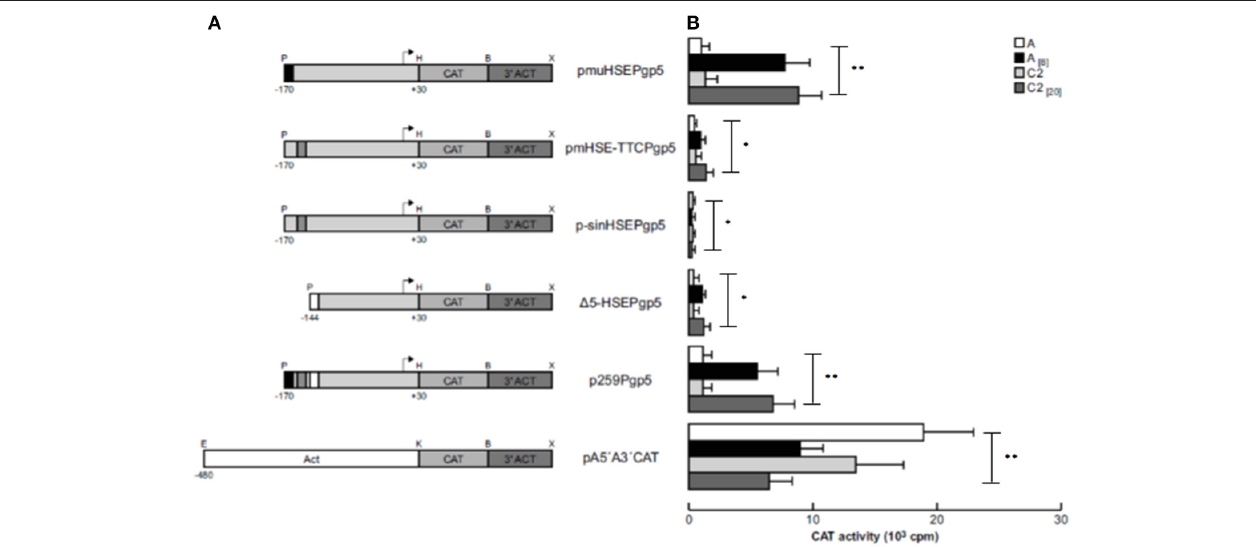
FIGURE 3 | Functional identification of the putative HSE element in the region from − 170 to − 111 bp of the EhPgp5 gene core promoter. (A) Schematic representation of the constructs used for the transfection assays. All of the plasmids contain the CAT reporter gene and the 3 ′ -flanking actin region (3 ′ ACT). Arrows, transcription initiation sites. P, Pst I; H, Hind III; B, Bam HI; X, Xho I; E, EcoR I; K, Kpn I. CdxA, YY1, and HSE motifs are in black, gray and white boxes, respectively. (B) Bars show the average CAT activity (cpm) of the transfected plasmids obtained by the two-phase diffusion assays ± SD, representative of three independent experiments performed in duplicate. The background given by the trophozoites transfected with pBSCAT-ACT plasmid was subtracted in all of the experiments. The efficiency of transfection assays was monitored by the activities given by the pA5 ′ A3 ′ CAT plasmid. Vertical bars and asterisks indicate significant differences (* p < 0.05; ** p <